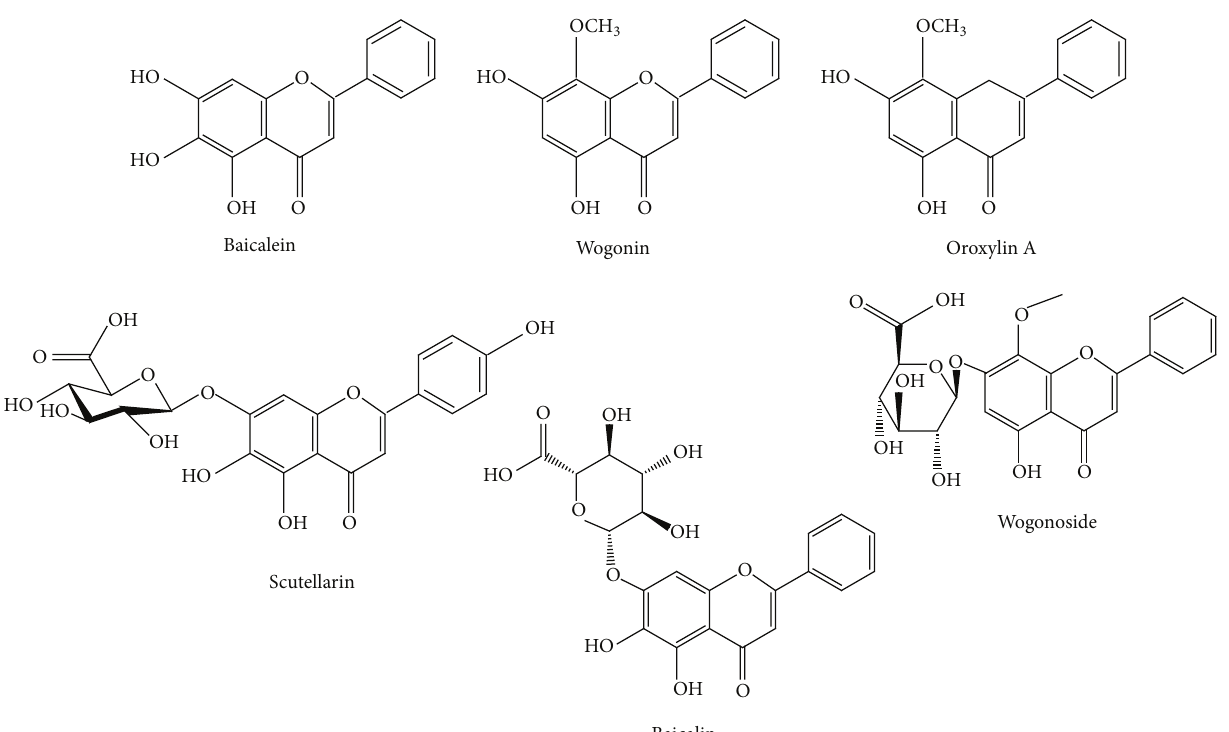
Figure 5: Phytochemical compounds identified in the bioactive ethanol extract of the root of Scutellaria baicalensis Georgi. These compounds were identified using LC-ESI-MS analysis.